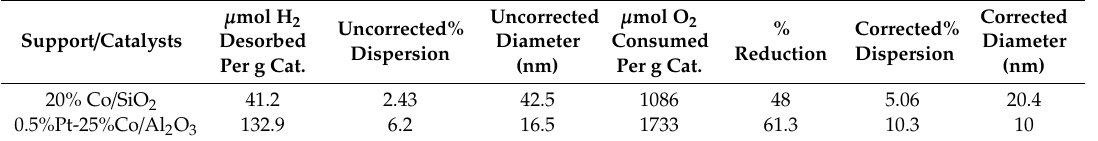
Table 9. H 2 chemisorption (temperature-programmed desorption (TPD)) and pulse reoxidation of metallic phases of cobalt-supported catalysts